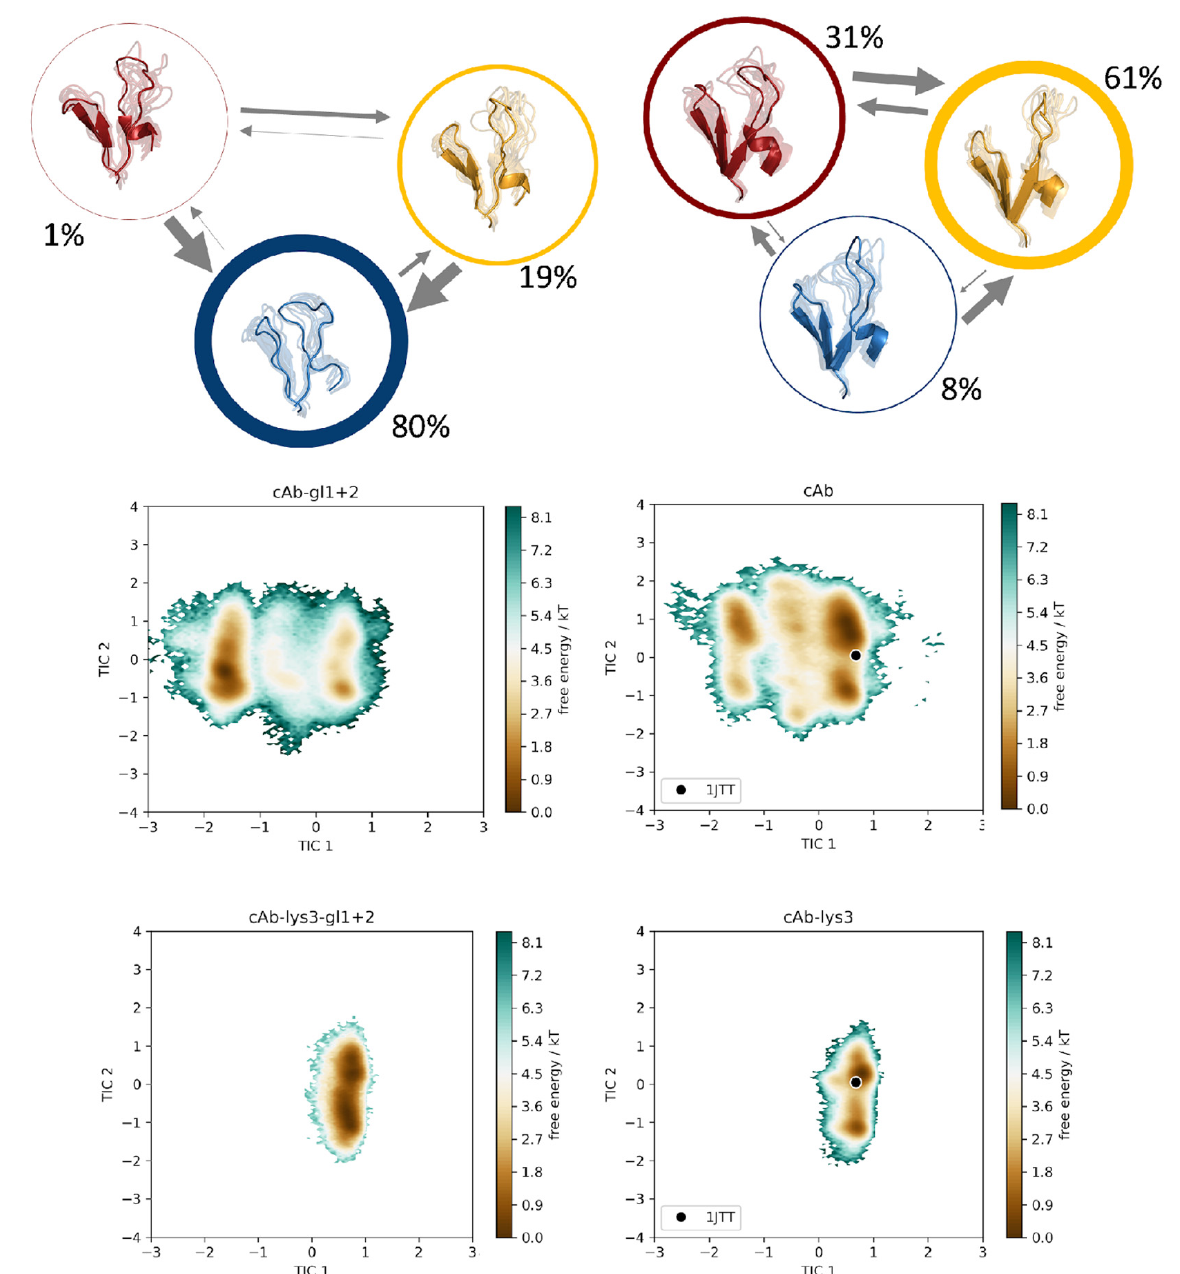
Figure 5. Markov-state models for the germline variant cAb-gl1+2 and for the cAb variant. The simulations were performed without antigen present. The respective state probabilities are shown as percentages and reflected in the thickness of the respective circles. Faster transition timescales are represented as thicker arrows connecting the respective states. For each trajectory, the conformational tICA spaces are shown, projected into the same coordinate system together with the simulations of the bound structures (cAb-lys3-gl1+2 and cAb-lys3). The projection of the available crystal structure (PDB: 1JTT) is shown in the same coordinate system.